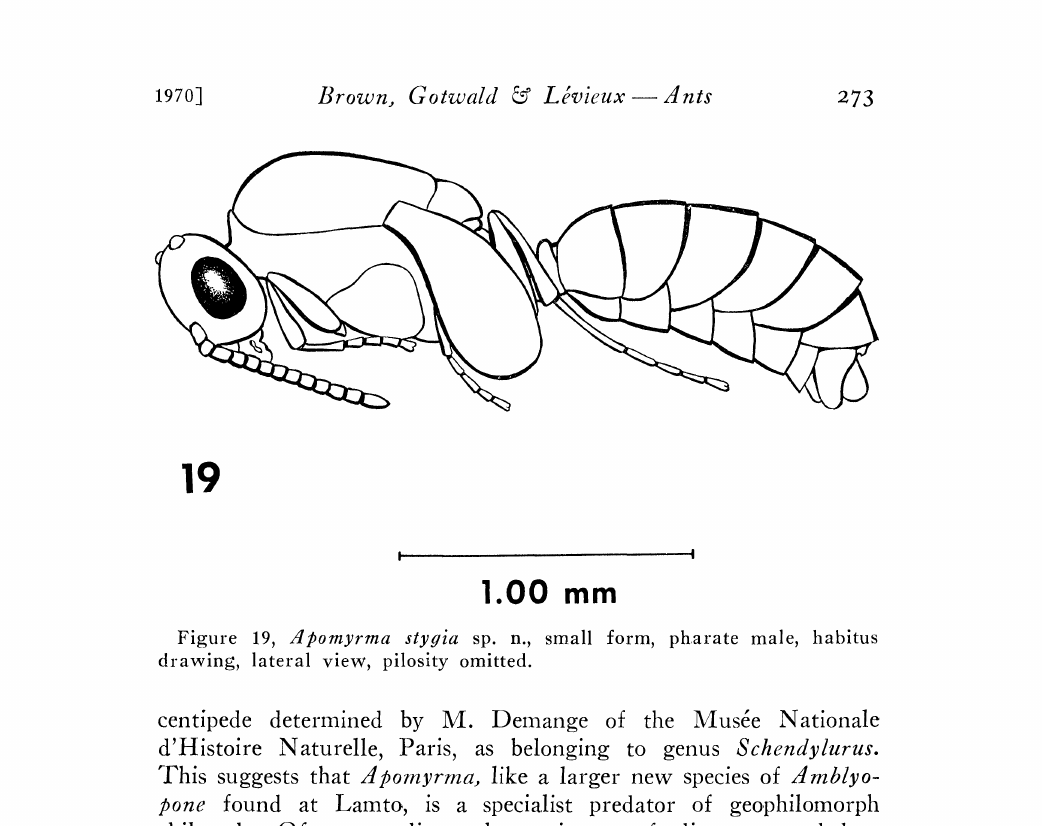
Figure 19, /lpomyrma stylia sp. n., small form, pharate male, habitus drawing, lateral view, pilosity omitted. centipede determined by M. Demange of the Muse Nationale d’Histoire Naturelle, Paris, as belonging to genus